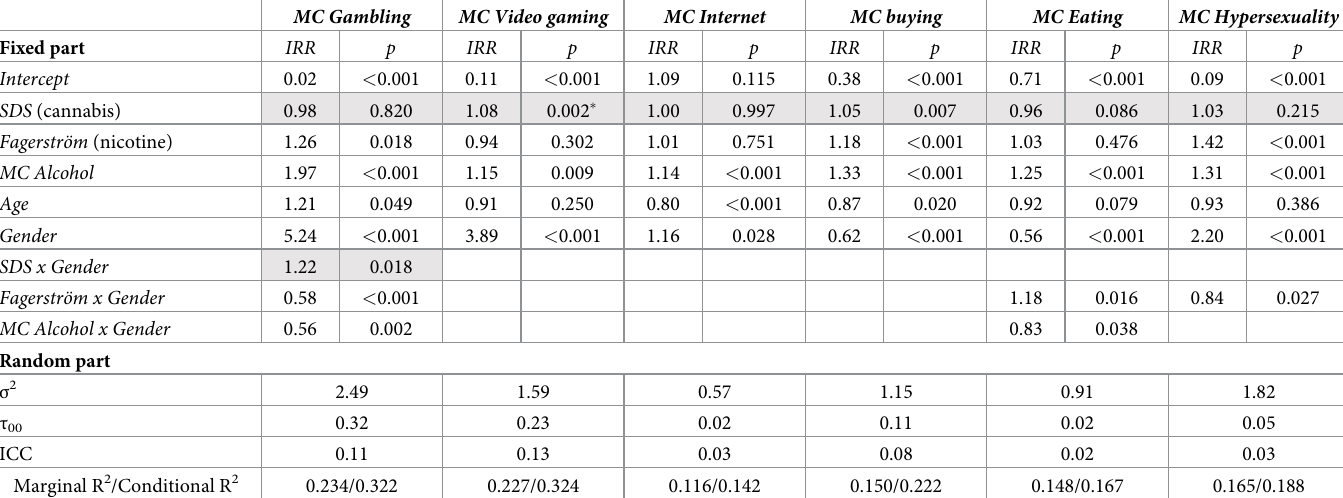
Table 2. Mixed-effect regressions for non-substance MultiCAGE dysregulated behavior scores over SDS cannabis score and relevant covariates.